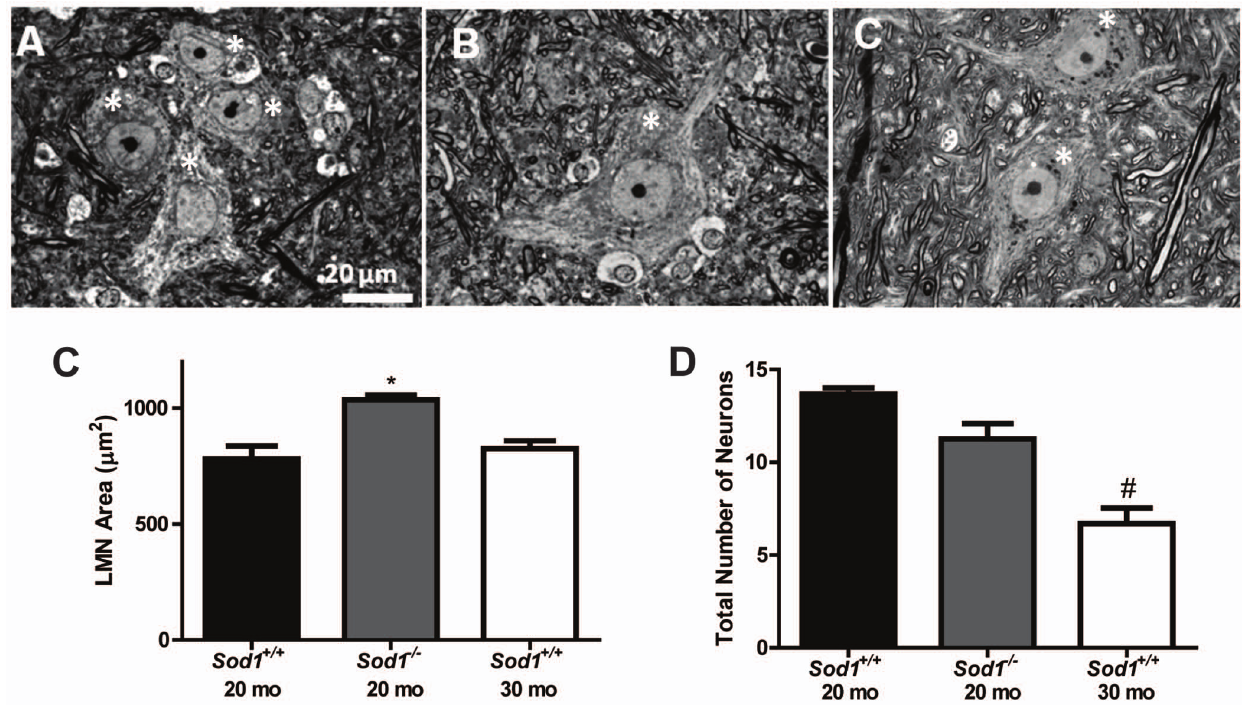
Figure 7. Structural deficits in the cell body of motor neurons using light microscopy. The cell body of lower motor neurons (LMN; asterisks), located in the spinal cord, was assessed by light microscopy. A) Sod1 + / + mice at 20 mo, B) Sod1 2 / 2 mice at 20 mo, and C) Sod1 + / + mice at 30 mo. Scale bar=20 m m. D) The area of LMN in the spinal cord (L 5 ) and E) the number of LMN was quantified. *p , 0.05 compared to age-matched Sod1 + / + mice and # p , 0.0001 compared to Sod1 + / + mice at 20 mo.